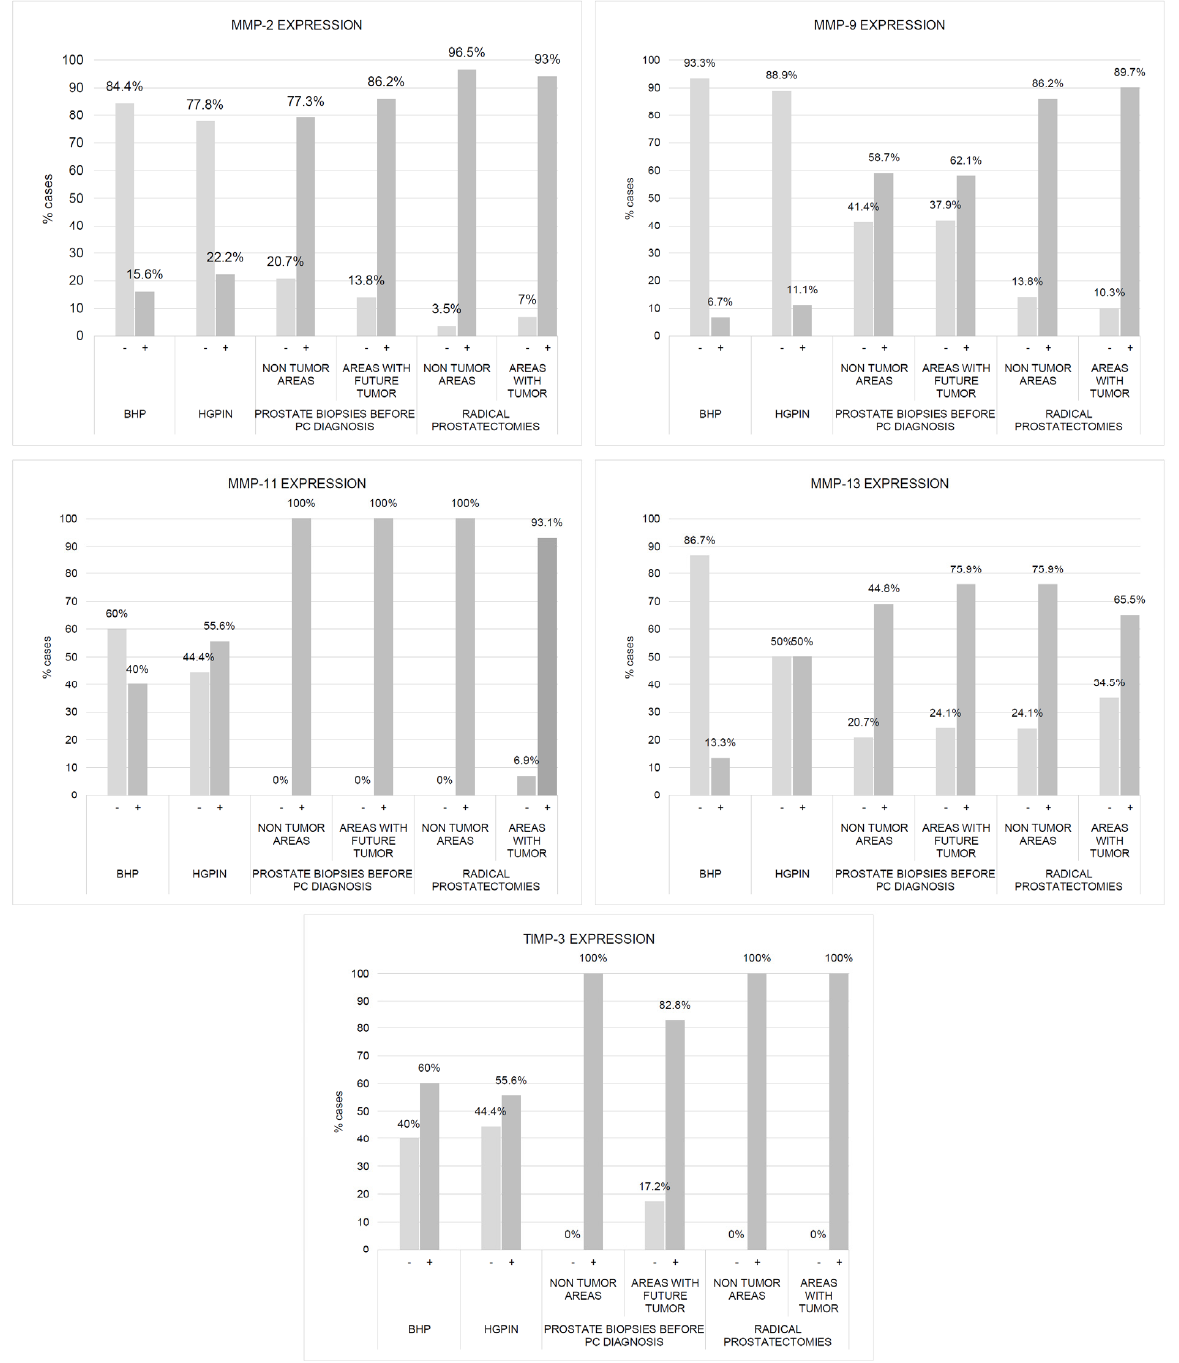
Figure 2. Expression of MMPs and TIMP-3 by epithelial cells from benign prostatic hyperplasia (BHP), high-grade prostatic intraepithelial neoplasia (HGPIN), benign prostate biopsies before the diagnosis of prostate cancer (non-tumor zones and zones with future tumor), and from paired zones from prostatectomies by prostate cancer (non-tumor zone and zone with tumor). The values represent the percentages of cases. Columns represent the number of cases of each series.